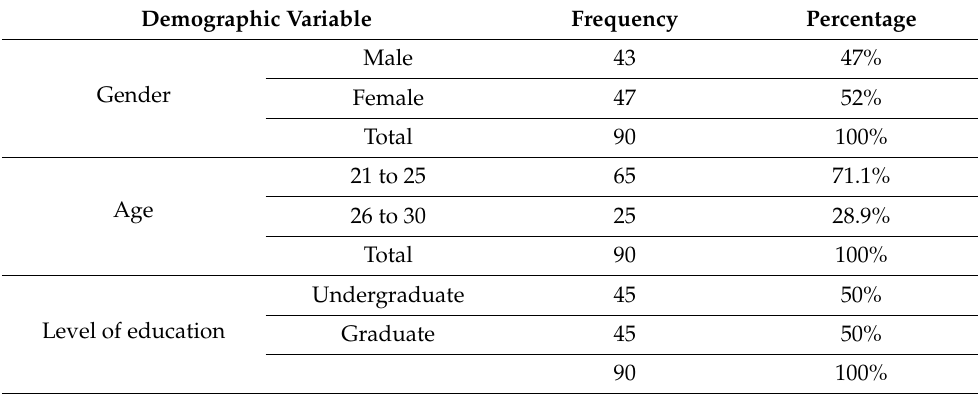
Table 1. Sample size distribution of participants.